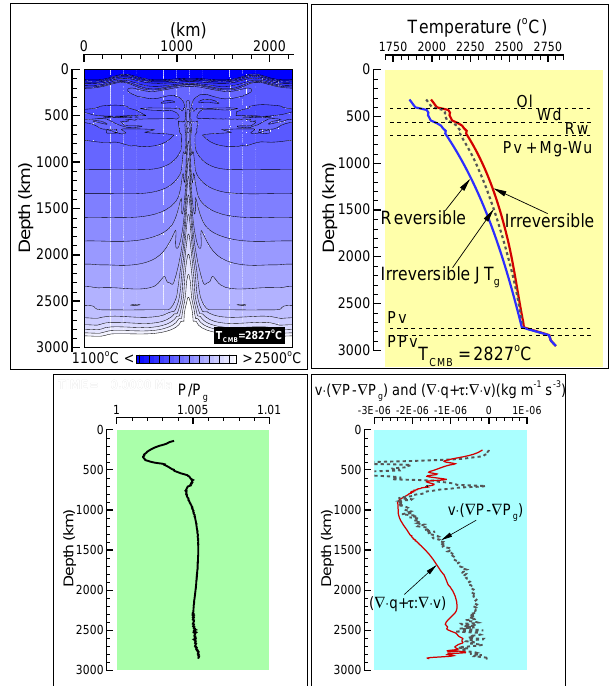
Figure 3. The top left panel shows the dynamic model of a thermal plume coupled with a thermodynamic formulation, including the ir- reversible effect of heat conduction, viscous dissipation and chem- ical transformations. The right panel shows the comparison of the thermal profile along the plume vertical section between the numer- ical model that includes the irreversible effects (from the simulation shown on the left panel) and the thermal gradient including the JT irreversible effect (dashed line). The reversible thermal profile is ob- tained by subtracting the integral of ( −∇× q − τ : ∇ v)(cid:49)z/(ρC p v z ) from the dynamic thermal model. The lower left panel shows the ratio between the flow pressure and the gravitational pressure. The lower right panel shows the irreversible contribution to the thermal gradient given by heat conduction and viscous dissipation for the plume model (solid line) and irreversible contribution in the JT for- mulation, including the gravitational effect (dashed